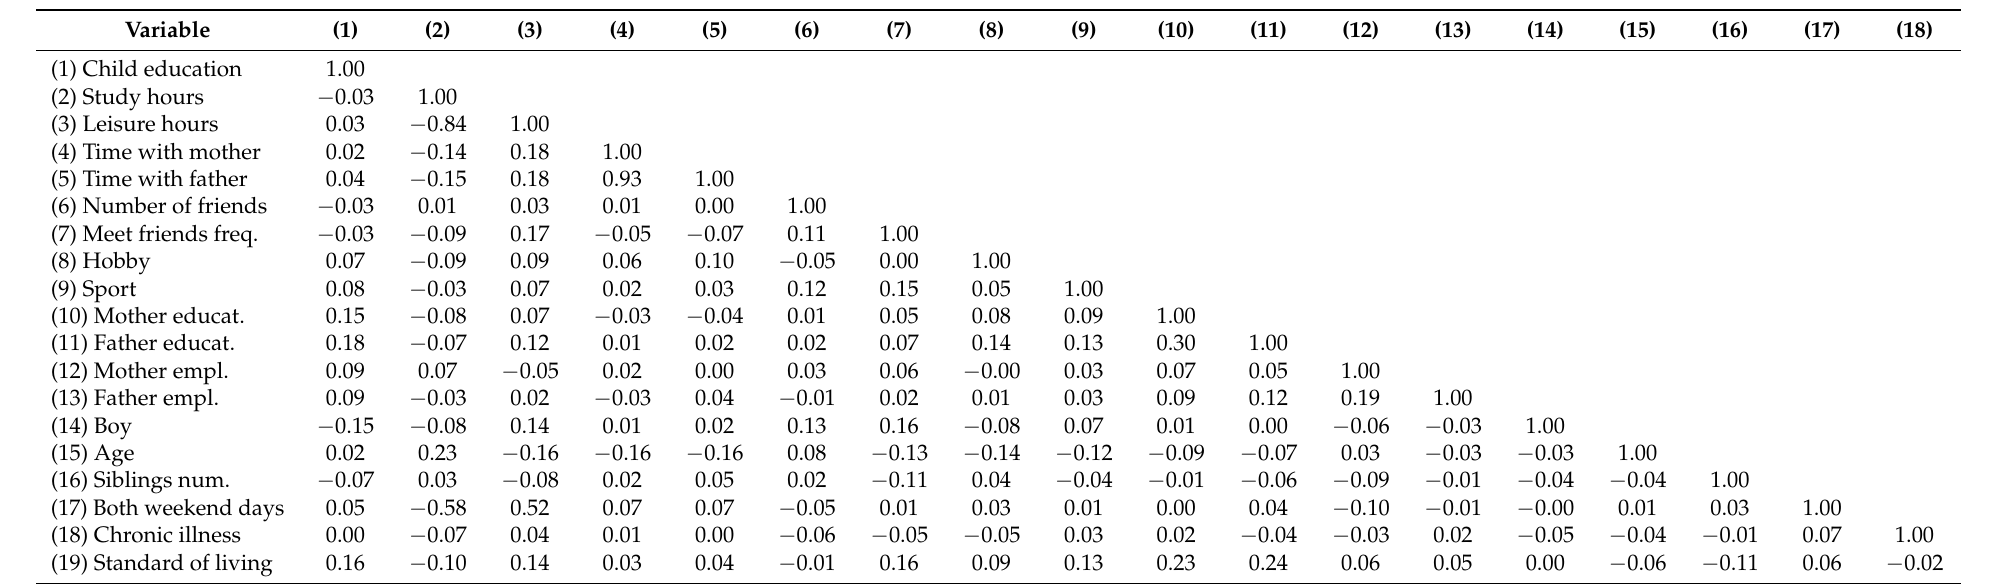
Table A1. Correlations (Spearman) between variables. FTUS 1979, children aged